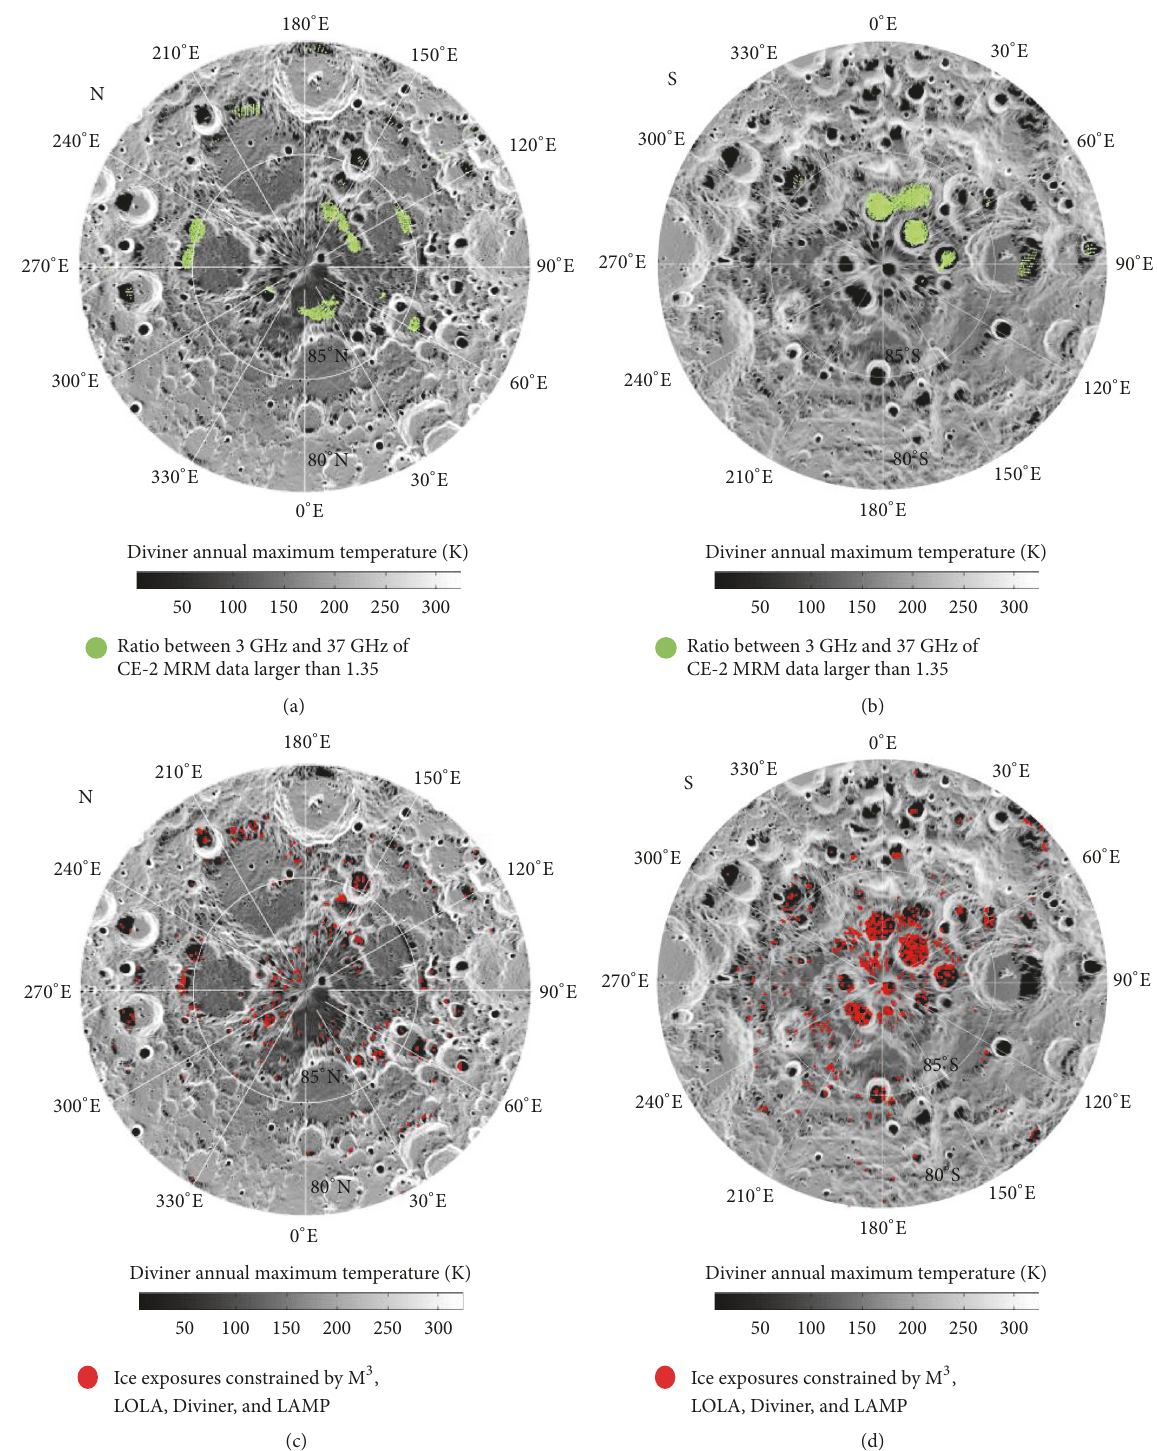
Figure 5: ((a) and (b)) Distribution of the ratio scattering points where it is no less than 1.35 overlain on the Diviner annual maximum temperaturefor the northern (a) and southern (b) polar regions; ((c) and (d)) Distribution of the water-ice-bearingpixels constrained by M 3 , LOLA, and Diviner, overlain on the Diviner annual maximum temperature for the northern (c) and southern (d) polar regions